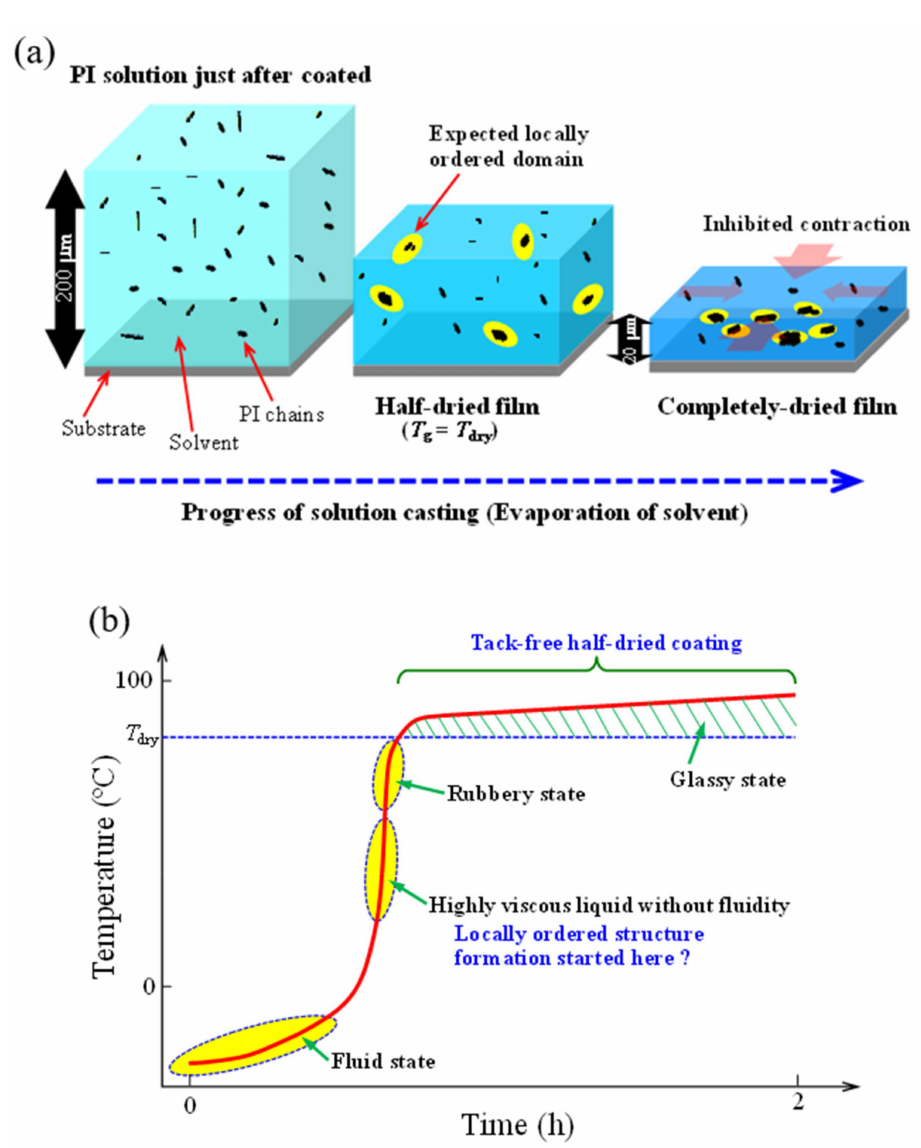
Figure 13. Predicted phenomena during the initial mild drying process at 80 ◦ C: ( a ) the formation of a locally ordered structure and generation of apparent stretching effect; ( b ) a schematic change in the T g of the coating accompanied with solvent evaporation and a concomitant decrease in coating